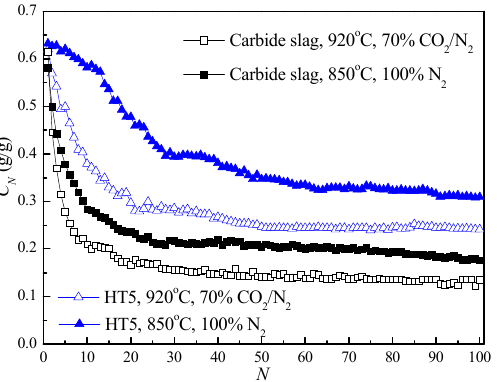
Figure 8. Long-term CO 2 capture capacities of HT5 (carbonation in 15% CO 2 /N 2 at 700 °C for 20 min, calcination for 10